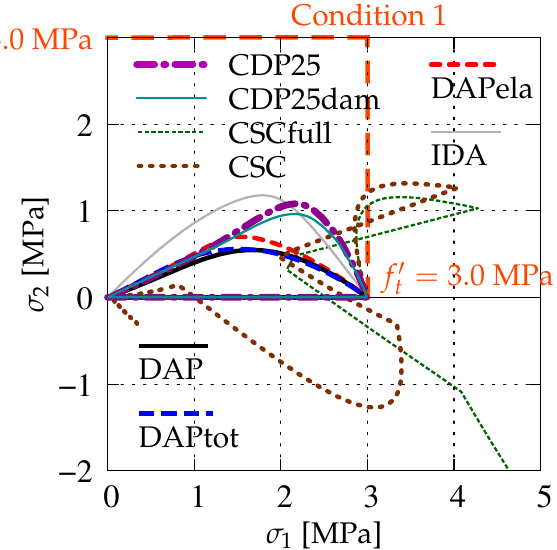
Figure 16. Comparison of models for evolution of principal